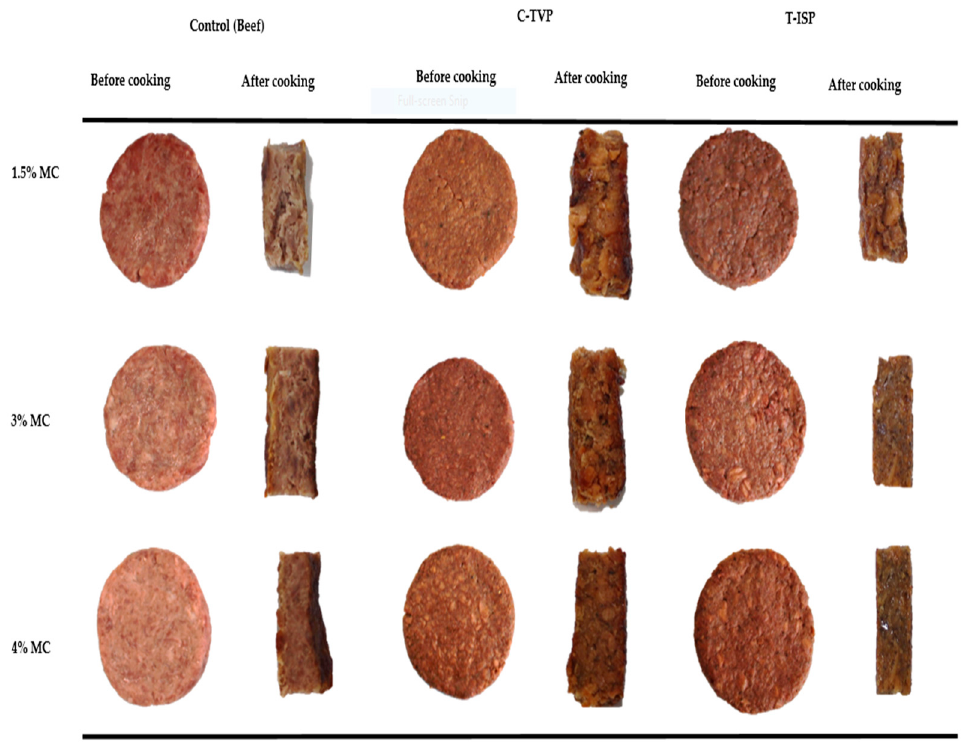
Figure 2. The external-internal appearance of cooked and uncooked plant-based meat patties.